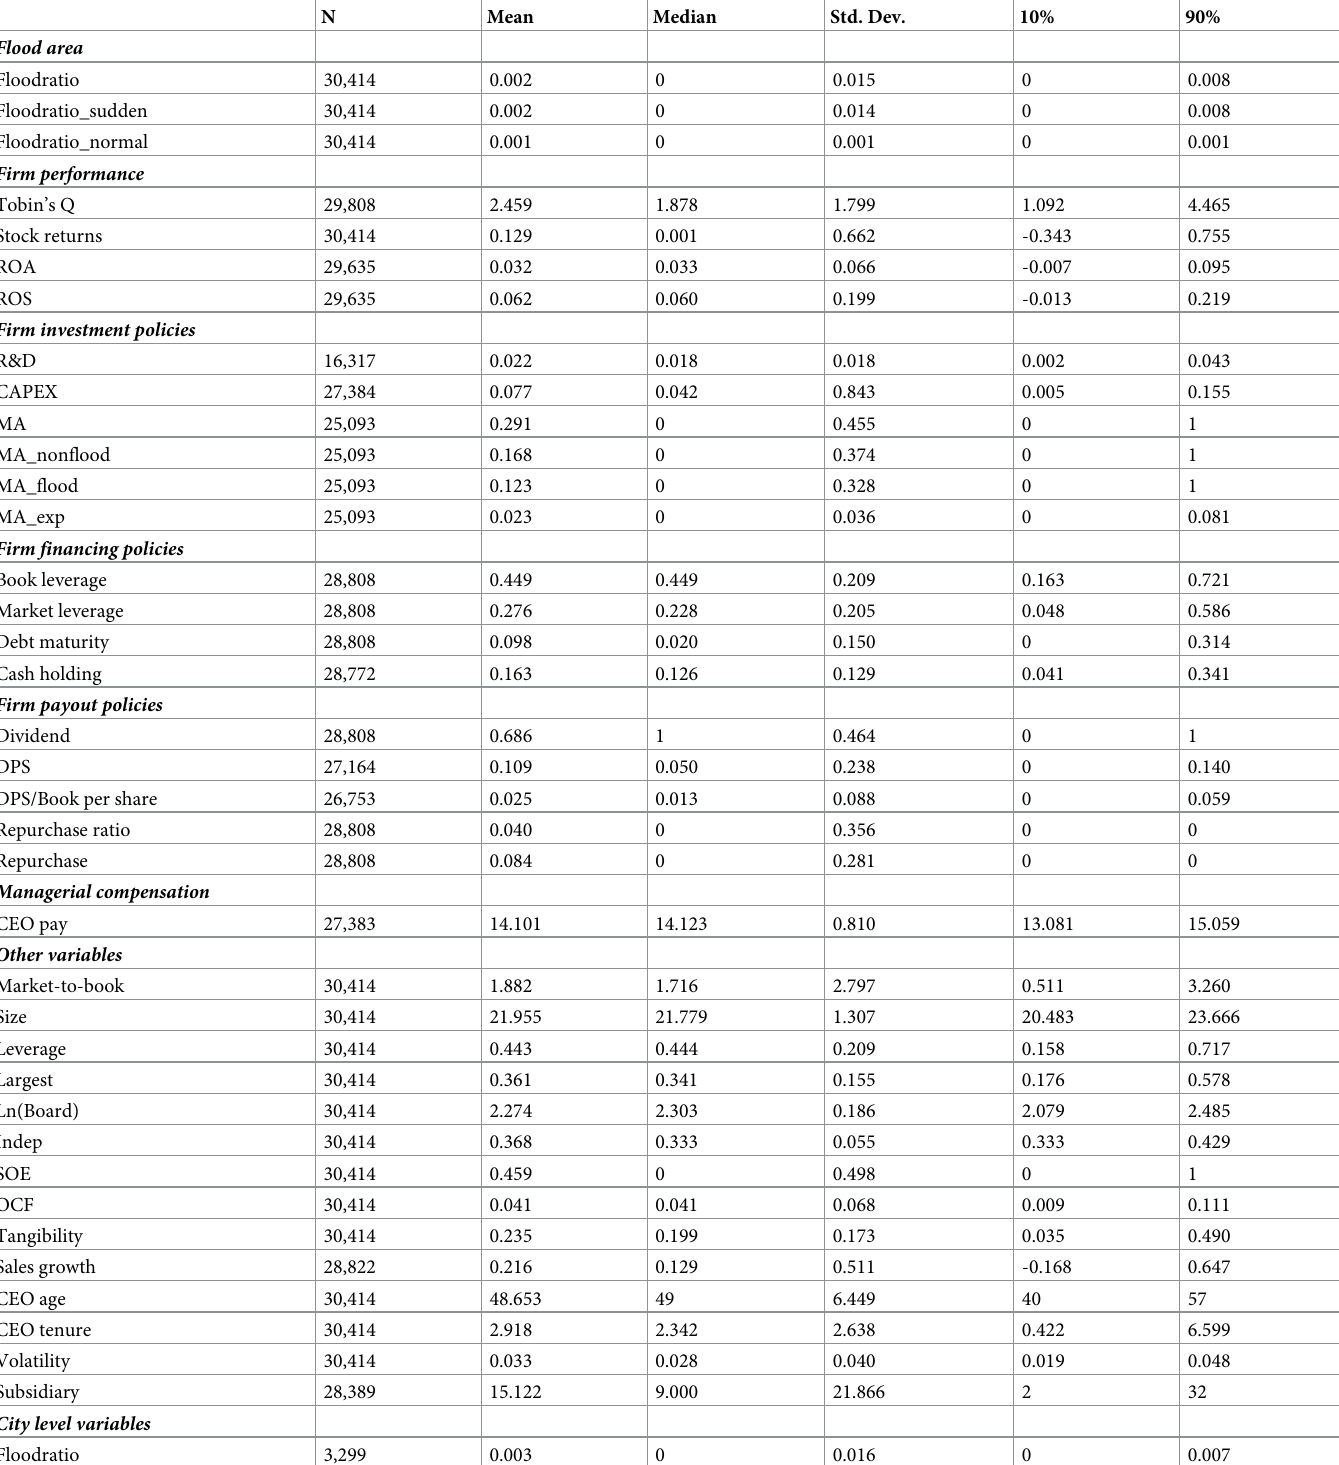
Table 1. Summary statistics. This table shows the summary statistics of all the variables used in this study. The sample period is from 2003 to 2019. Firm-year observa- tions from financial industry, flagged with either ST or ST � , with negative equity value are excluded. The final sample has a total of 30,414 firm-year observations and 2,891 unique firms. Variable definitions are in Table A1 in the S1